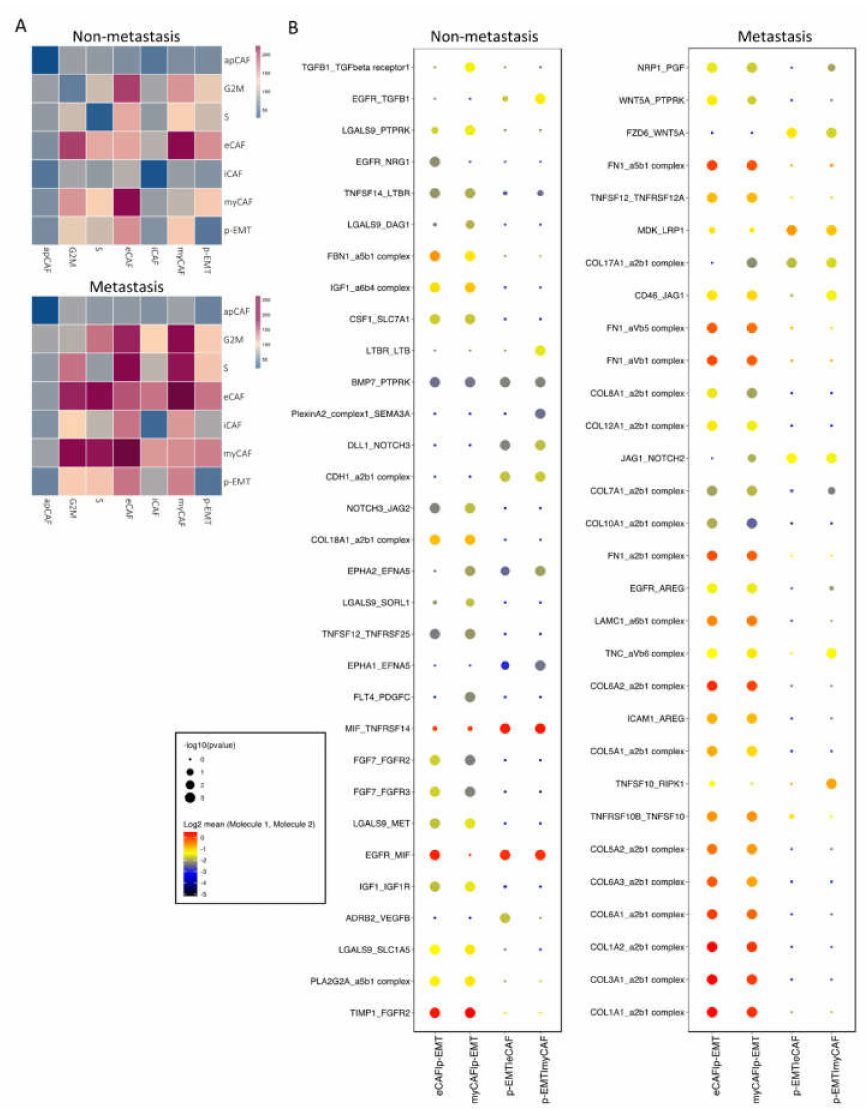
Figure 3. Cell–cell communication analysis in sub-clusters of fibroblasts and epithelial